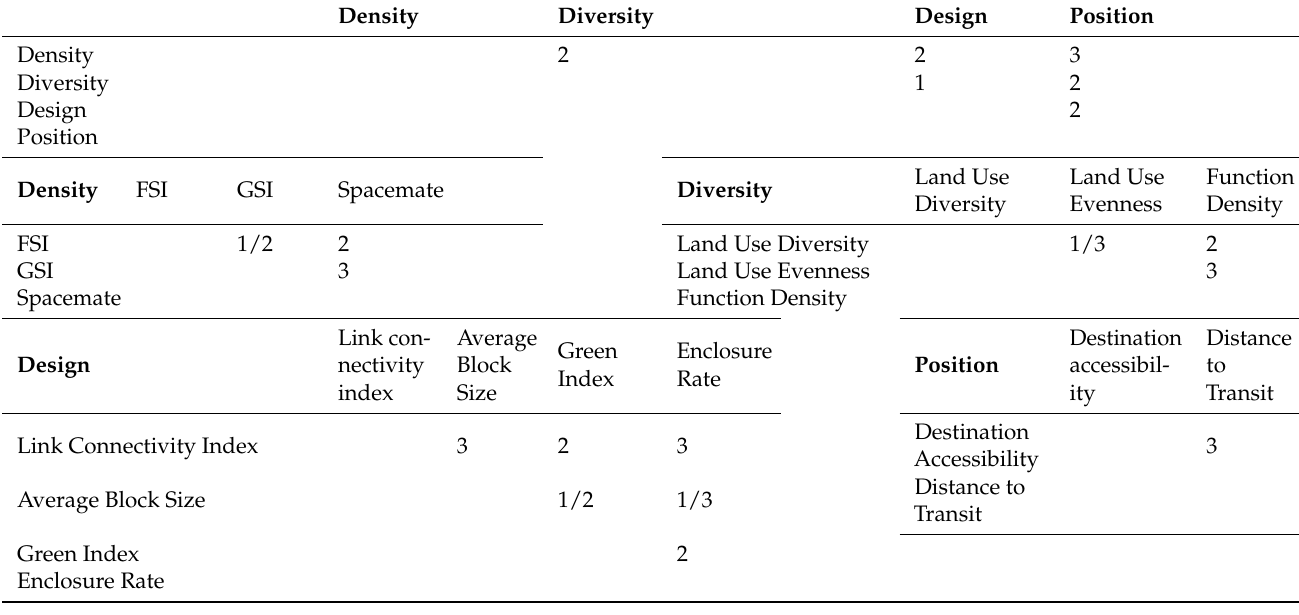
Table A2. Expert 2.